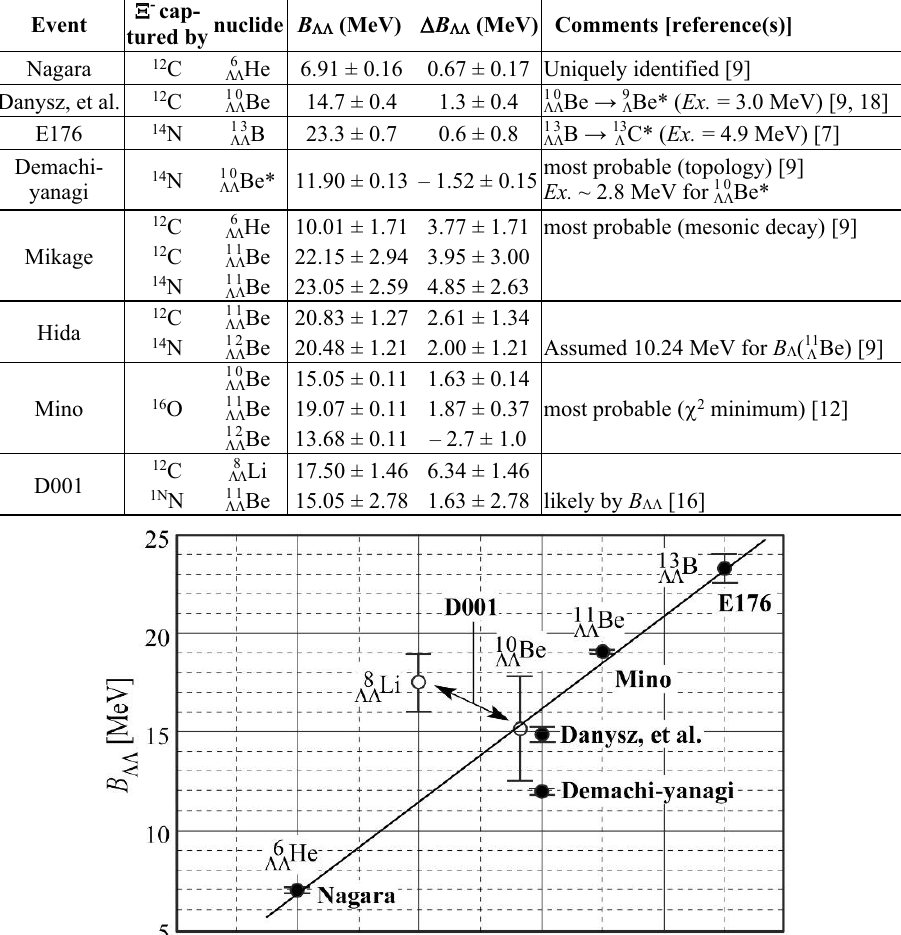
Fig. 1. Relationship between the mass number A and B (cid:2)(cid:2) for the most probable cases with small errors form Table